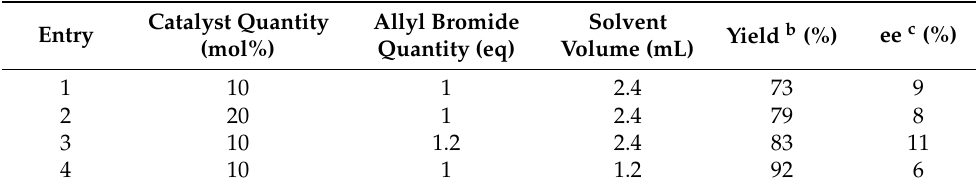
a Reaction conditions: tert -butyl methyl α -benzylmalonate (1 eq), allyl bromide reagent, C5 catalyst, 50% aq.